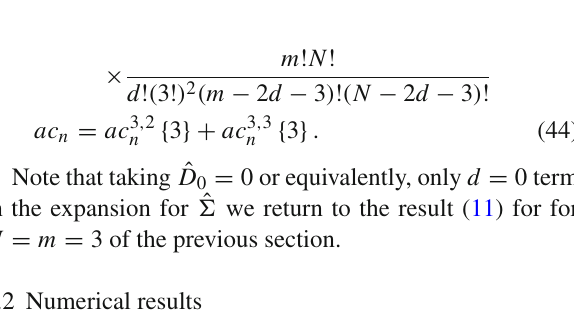
Fig. 10 Thedependenceofthemaximumvalueof ac 2 (asafunctionof momenta) on multiplicity m for different values of ¯ m where ˆ D 0 = 0 . 1 and N c = 3